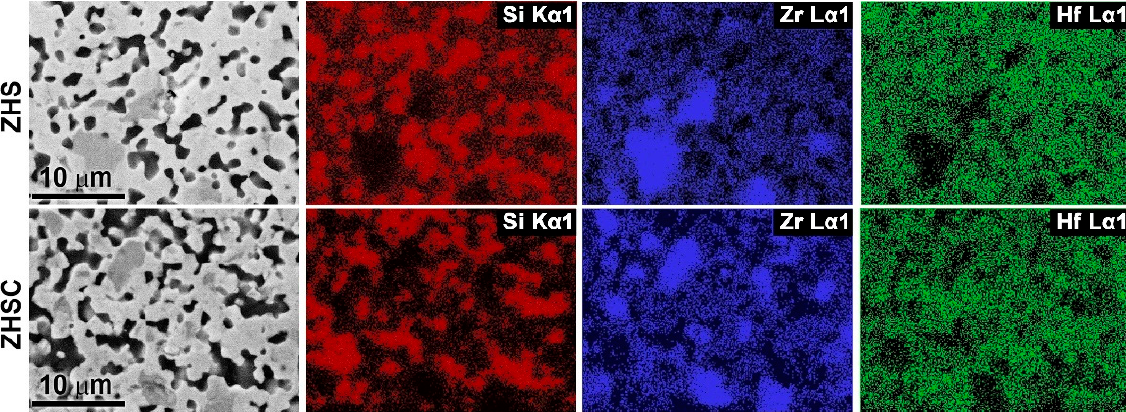
Figure 5. Mapping the distribution of elements Si, Zr, and Hf on thin sections of samples ZHS and ZHSC (EDX).